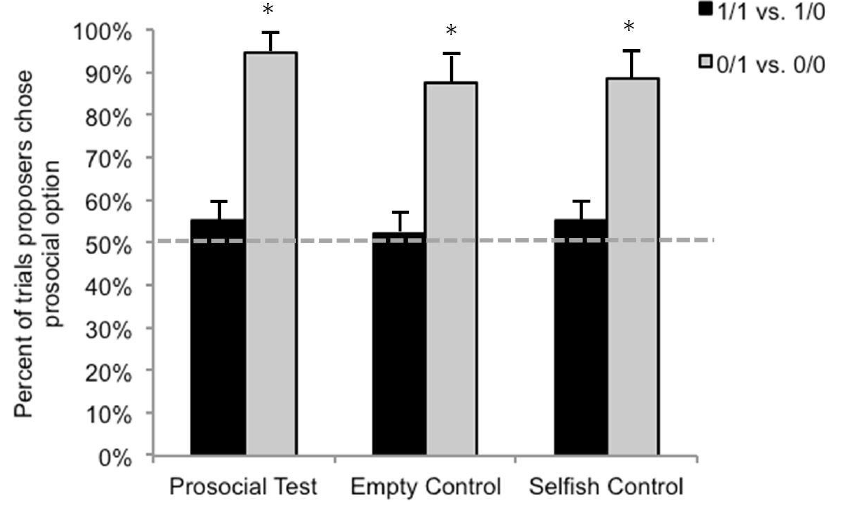
Figure 4. Mean percent (+SE) of prosocial choices by actors in the three conditions. Asterisks denote when actors’ behavior was significantly different from